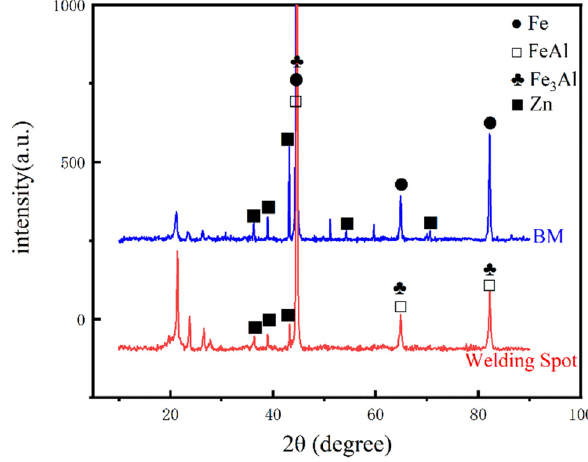
Figure 11: XRD analysis of